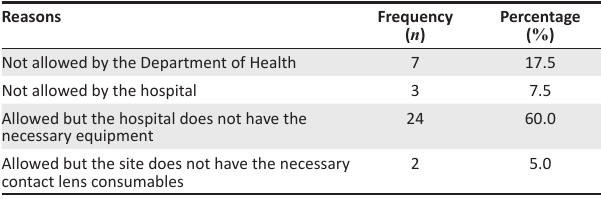
TABLE 3: Reasons cited for not fitting contact lenses.